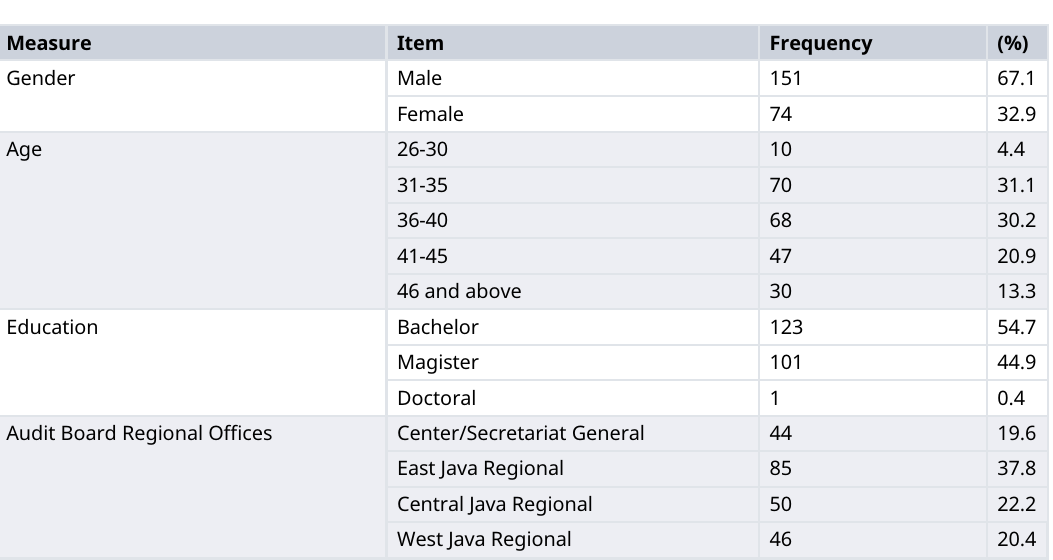
Table 2. Descriptive statistics on respondents.